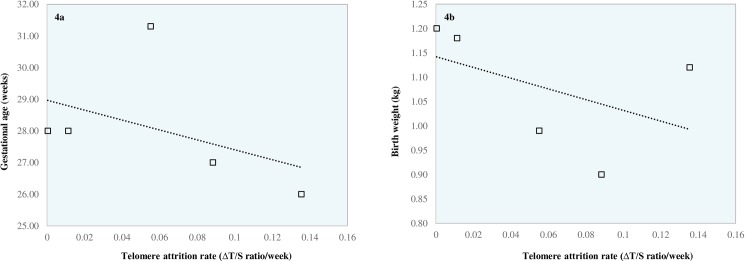
Relationship between telomere attrition rate (Δ T/S ratio per week) and birth gestation (a) and birth weight (b) in preterm infants with longitudinal samples.